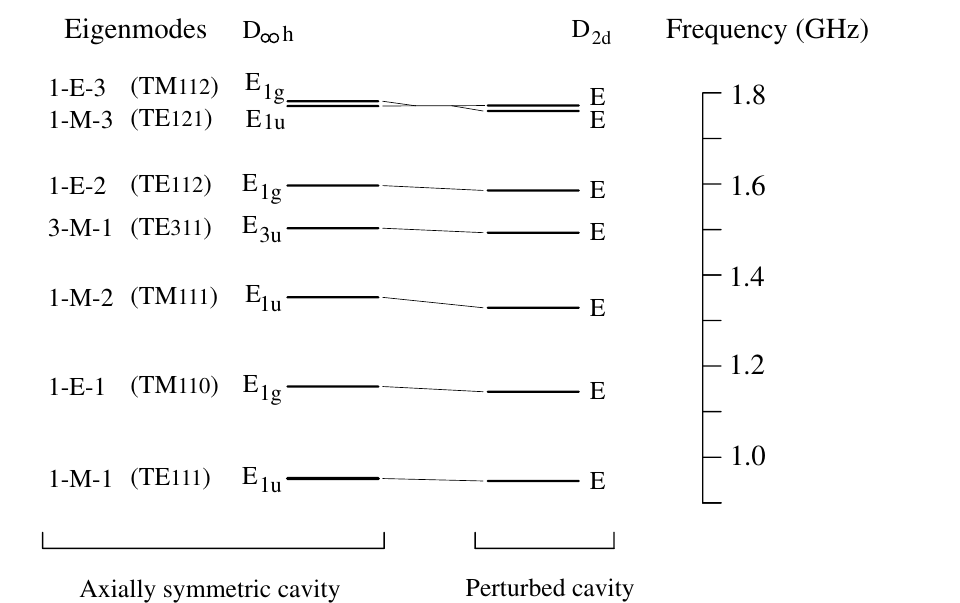
. The frequency range is 0.9–1.8 2